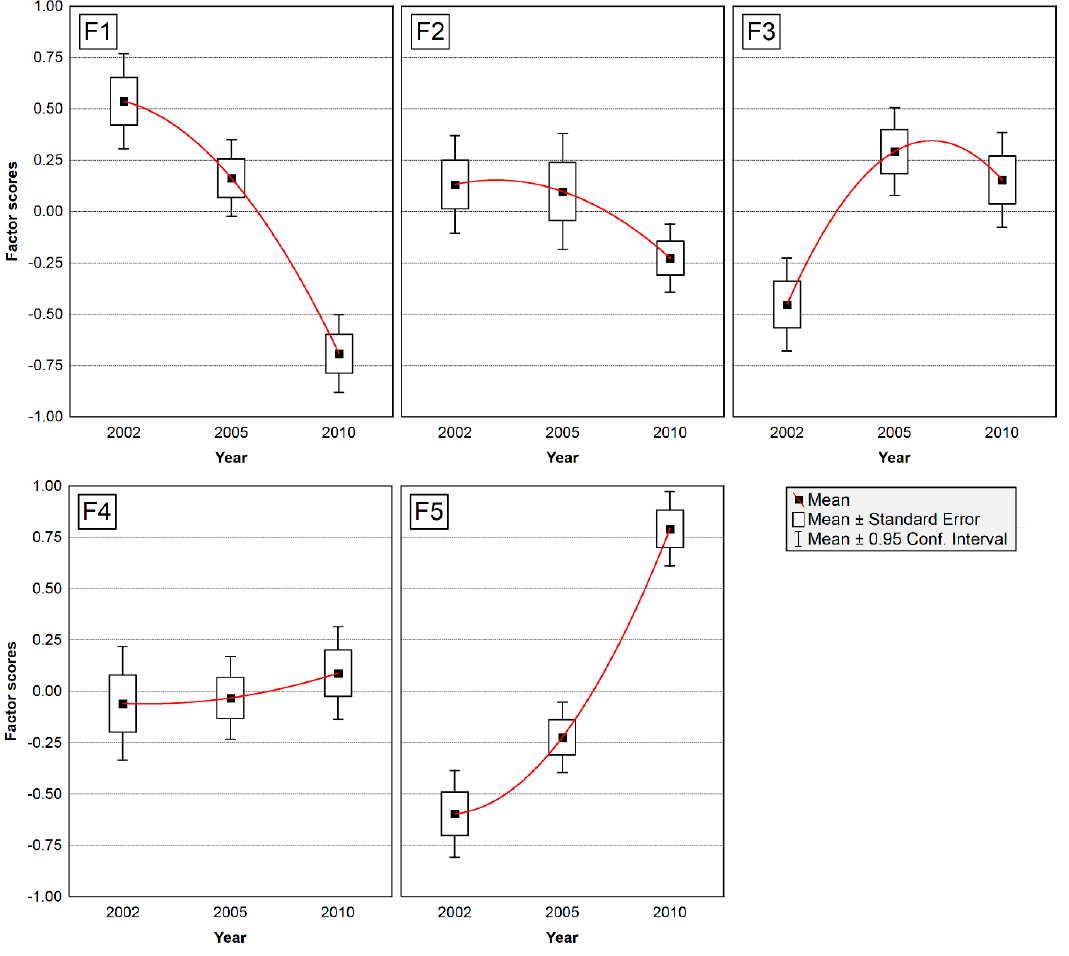
Figure 5. Box plots of factor scores (st. values) according to the sampling campaign. F1–F5—factor Figure5. Boxplotsoffactorscores(st. values)accordingtothesamplingcampaign. loadings.